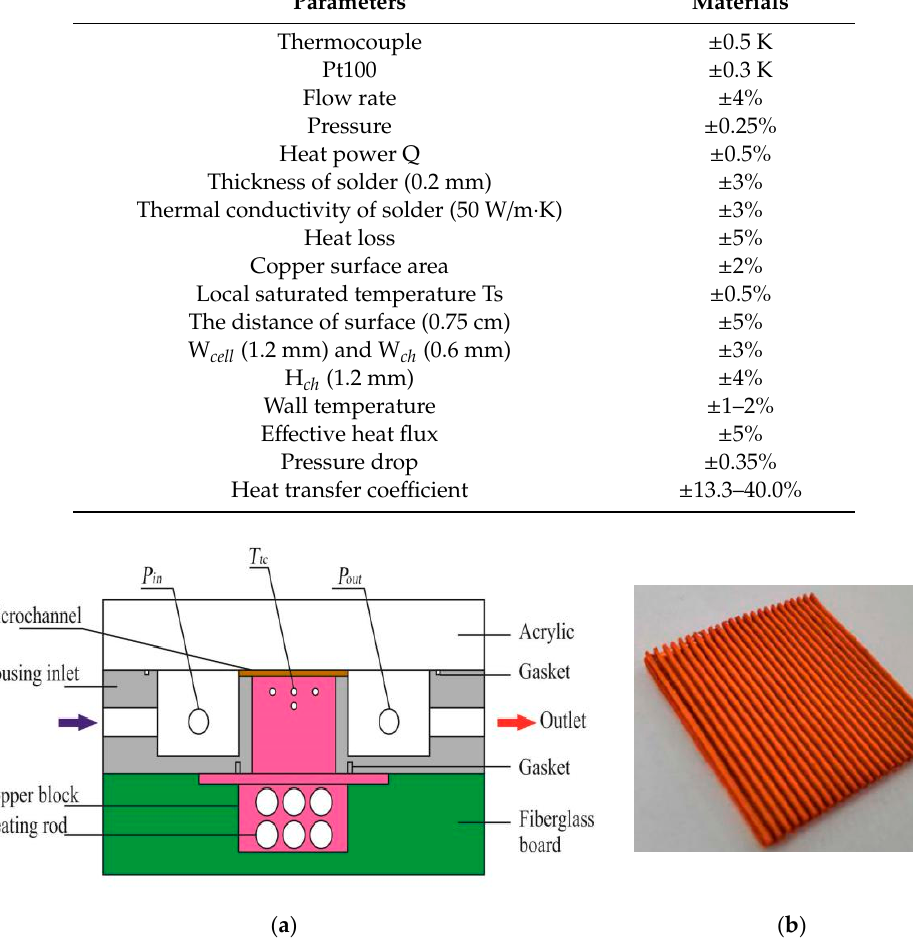
Figure 2. ( a ) Test section and ( b ) porous microchannel sample.